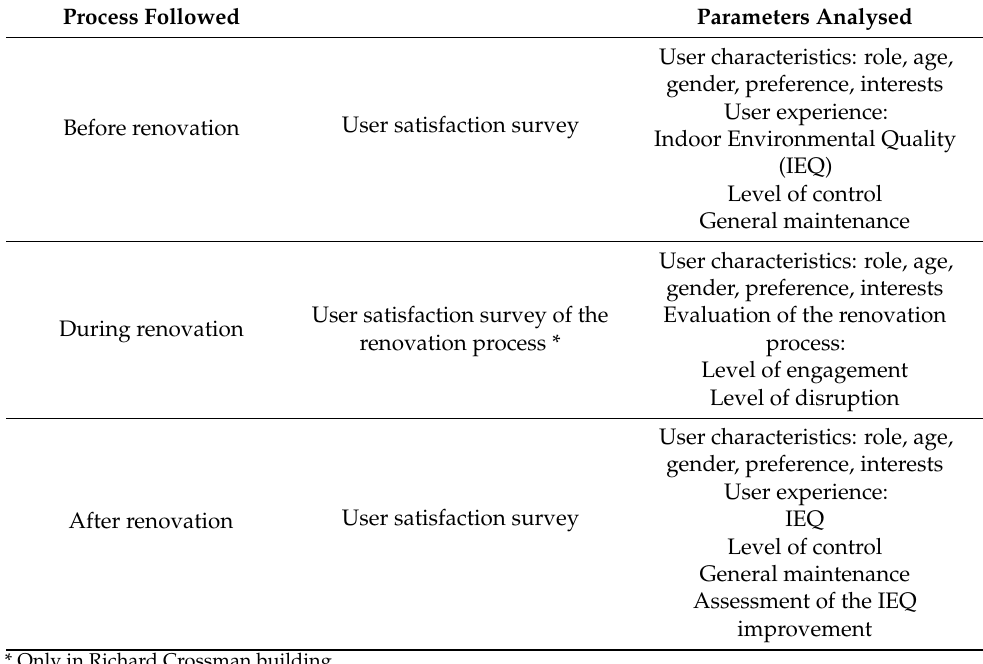
Table 5. Research method for user comfort evaluation.